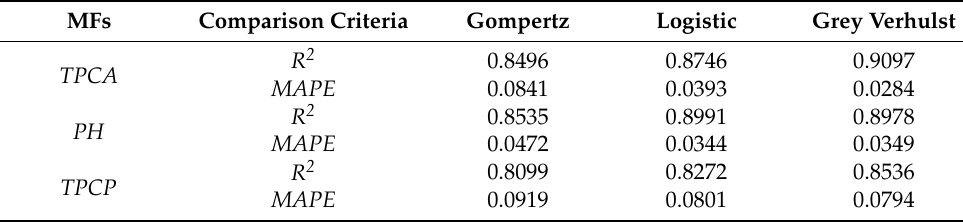
Table 3. Evaluation results for the TPCA , PH and TPCP growth